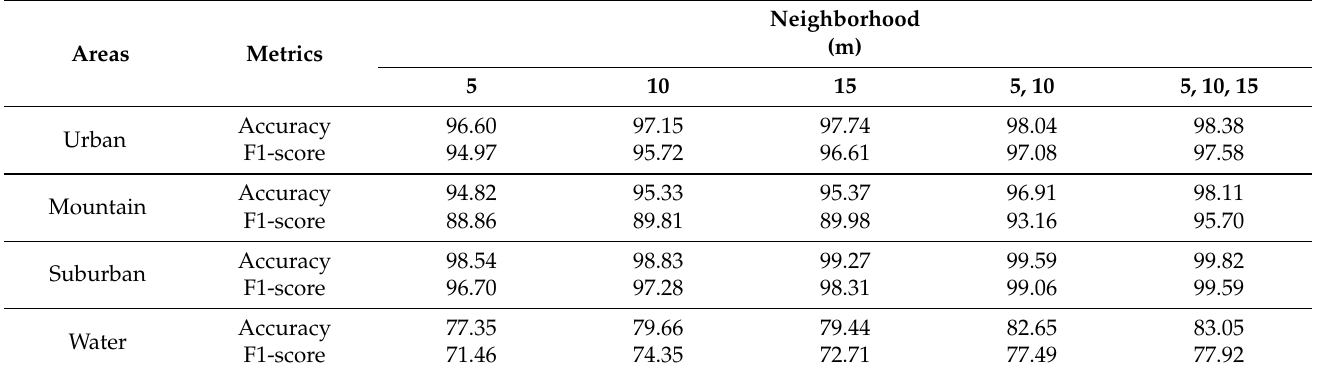
Figure 9. Examples of the denoising results in the water area. The four images in the upper right- hand corner show the profile line in the area of the red line on the left. The third row represents the profile line partial details for convenient comparison. The fourth row indicates the DSM gen- erated by the different denoising methods. The bottom row indicates some details of the DSM to facilitate comparison. Table 6. Performance evaluation of denoising by the proposed approach, using different scales in the urban, suburban, mountain, and water